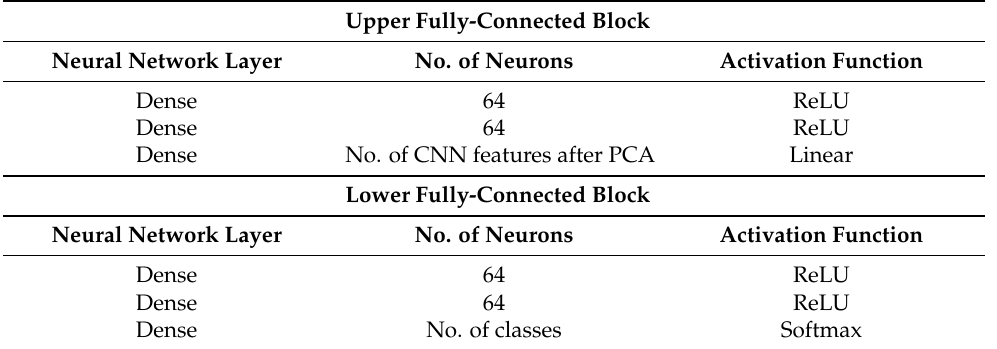
Table 8. Hybrid ANN architecture–ISL digits, Cambridge hand gesture dataset, ASL alphabet and ASL finger-spelling